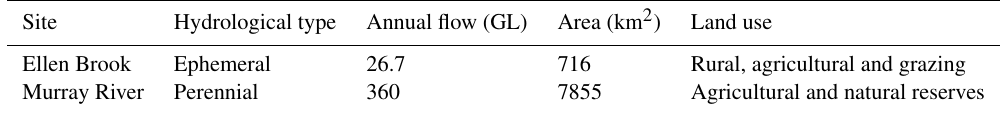
Table 2. Hydrological characteristics of the two tributaries.